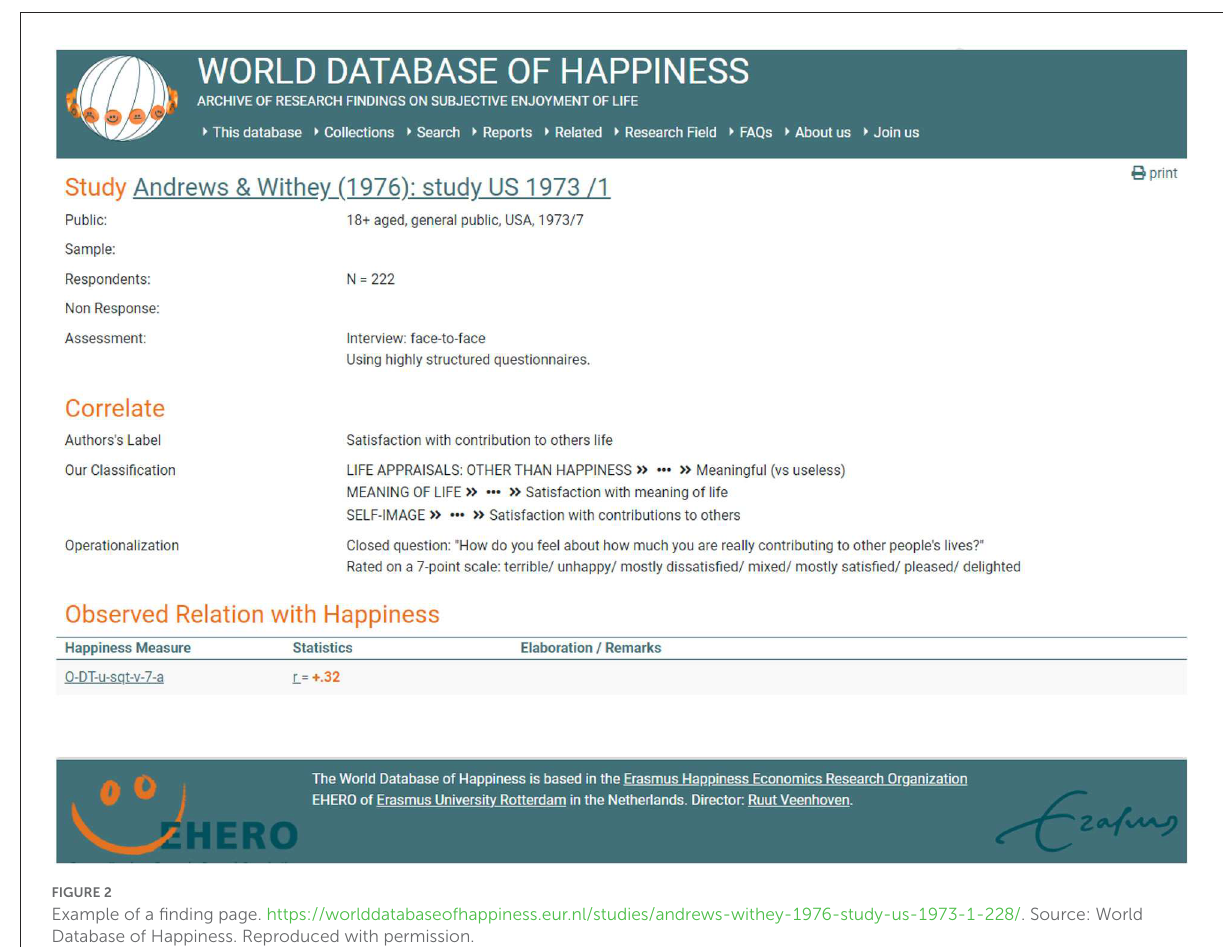
FIGURE2 Example of a finding page. https://worlddatabaseofhappiness.eur.nl/studies/andrews-withey-1976-study-us-1973-1-228/. Source: World Database of Happiness. Reproduced with